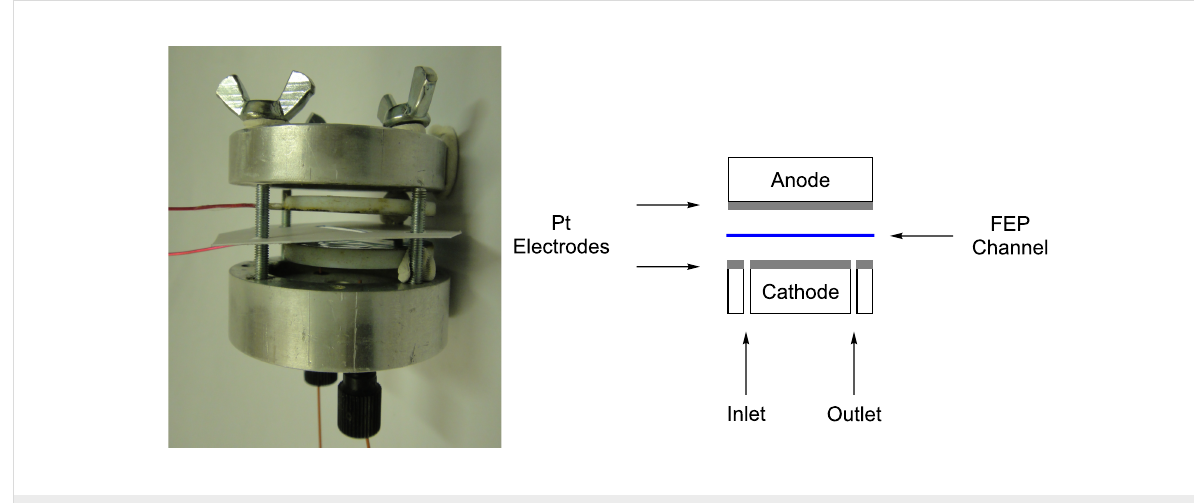
Figure 1: Electrochemical